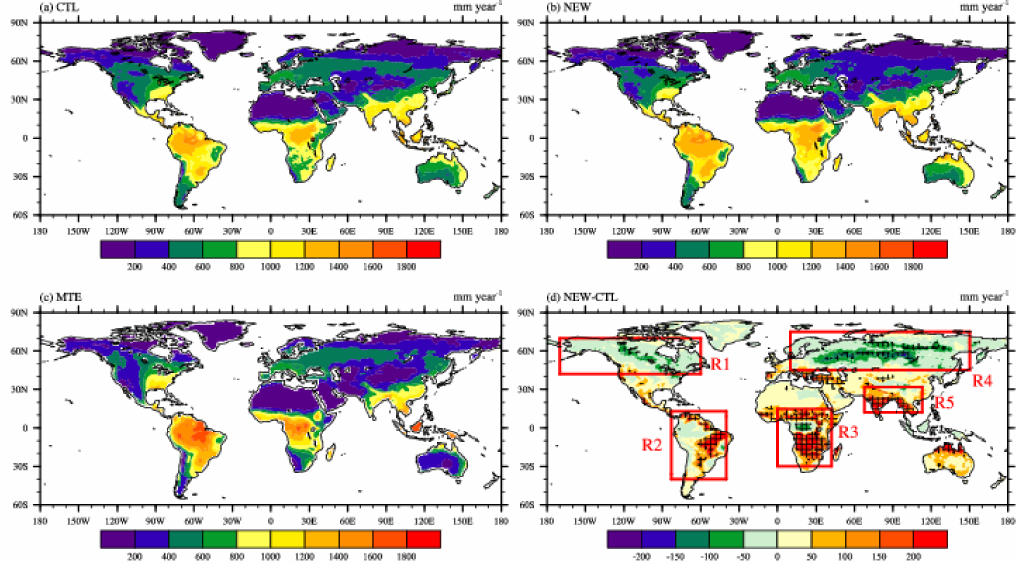
Figure 4. Annual evapotranspiration (ET, mm year − 1 ) over 1982–2005 for ( a ) the CTL run; ( b ) the NEW run; ( c ) Model Tree Ensembles (MTE); ( d ) the difference between NEW and CTL. (Grid shaded regions are significant at the 95% confidence level according to Student’s t -test, and the red frames outline typical regions with significant differences, denoted as R1, R2, R3, R4, and